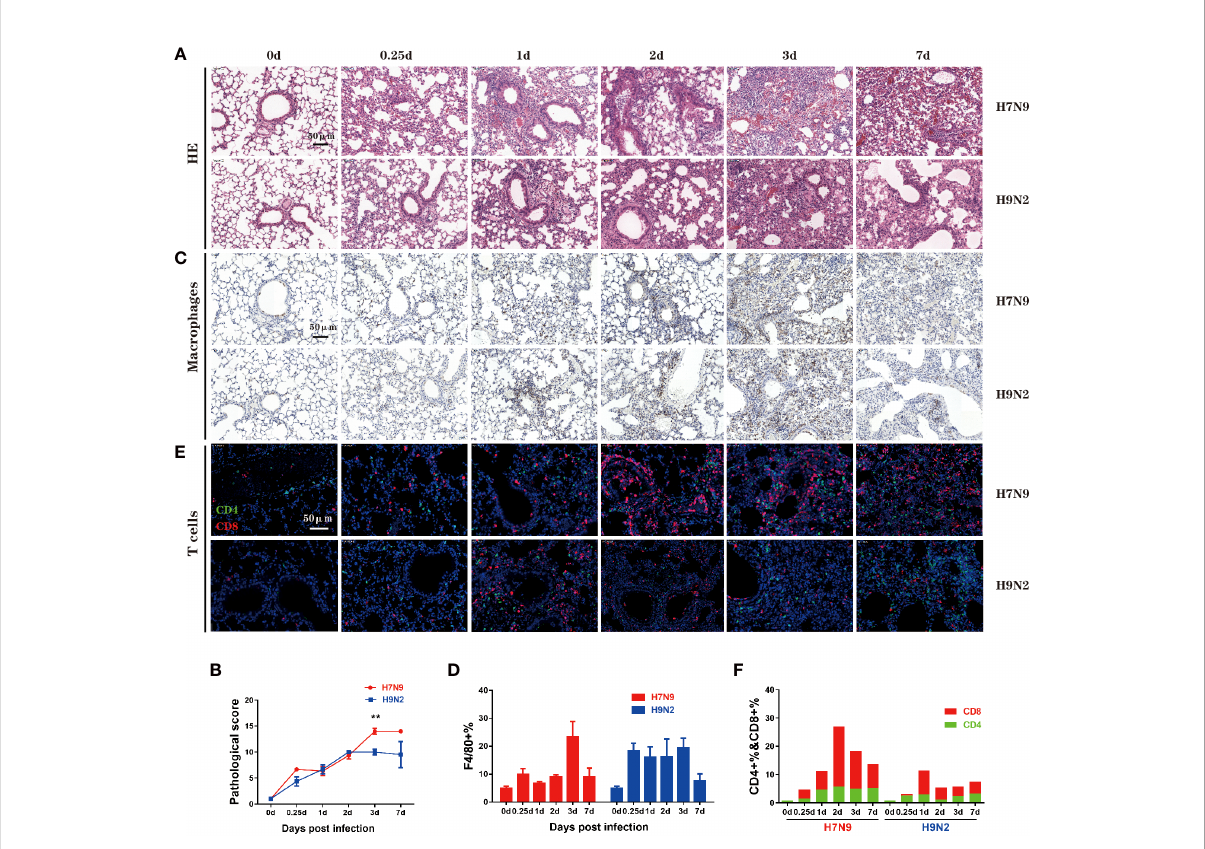
FIGURE 3 Comparative analysis of lung pathology and immune cell in fi ltration. (A) Lung tissue harvested at 0,0.25,1,2,3, and 7 dpi. from mice that had been infected H7N9 or H9N2 avian in fl uenza virus was stained with H&E. (B) Quanti fi ed pathological scores derived from the calculation of lung histology data. (C) Immuno-histochemical detection of total macrophages in the lung sections by staining with anti-F4/80 antibody, with nuclei counterstained by hematoxylin. Brown signals indicate detected macrophages. (D) Summation data of the measurements of lung macrophages. (E) Immuno fl uorescence detection of CD4+ plus CD8+ T cells in the lung sections by sequential staining with anti-CD4 and anti-CD8 antibodies, with nuclei counterstained by DAPI. Red and green signals indicate detected CD8+ and CD4+ T cells, respectively. (F) Summation data of the measurements of CD4+ and CD8+ T cells in the lung. n=3 mice for each group per time point. **P < 0.01 by unpaired t